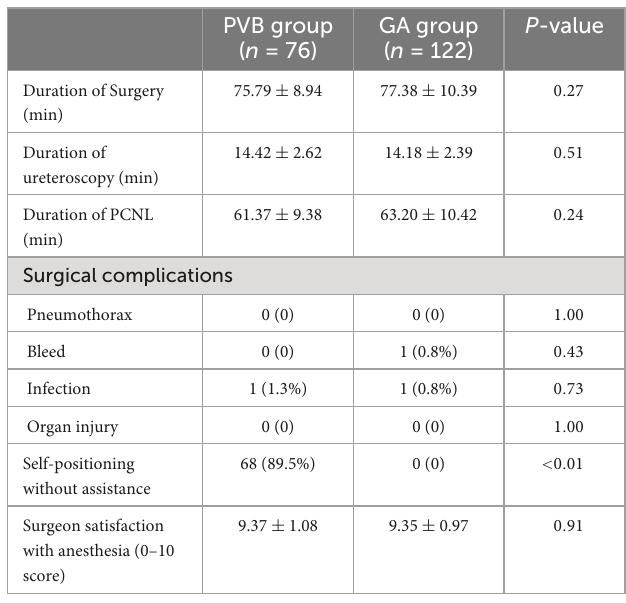
TABLE 2 Clinical parameters of surgery.